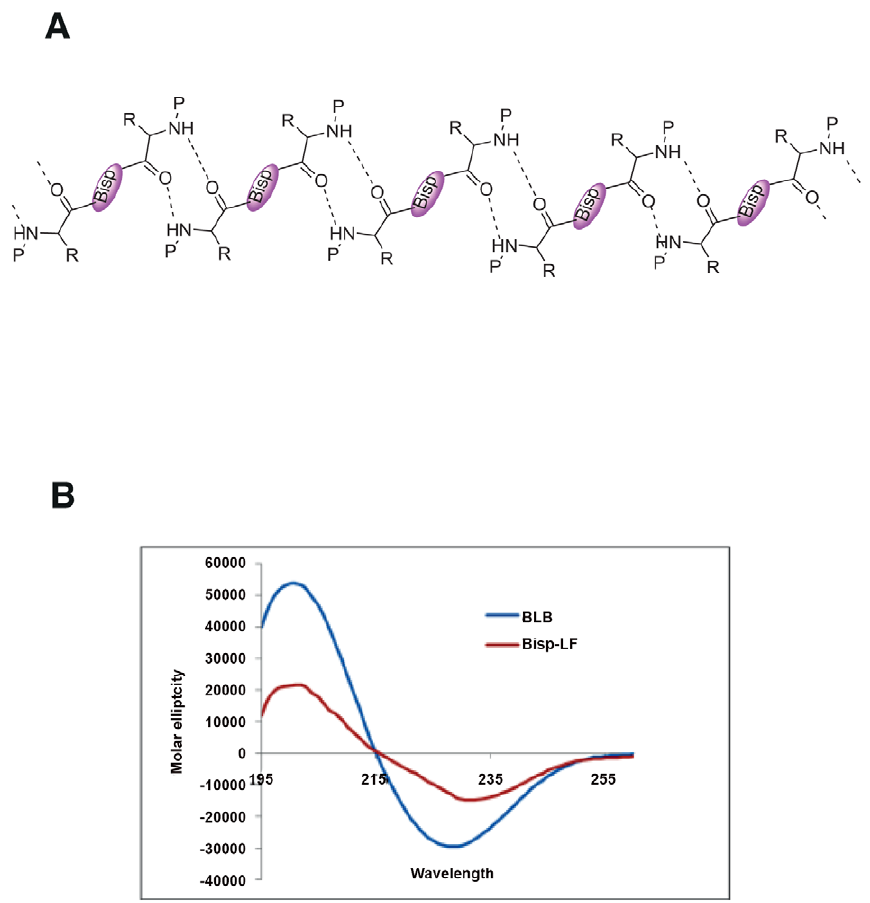
Figure 7. Bispidine conjugates as secondary structure mimetics. (A) Secondary structure showing a b -sheet-like arrangement of BLB in the solid state involving a 10 membered H-bonded ring. (B) CD spectra of 500 m M of Bisp-LF, BLB in MeOH.